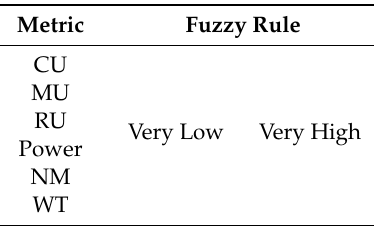
Table 12. Policy of case